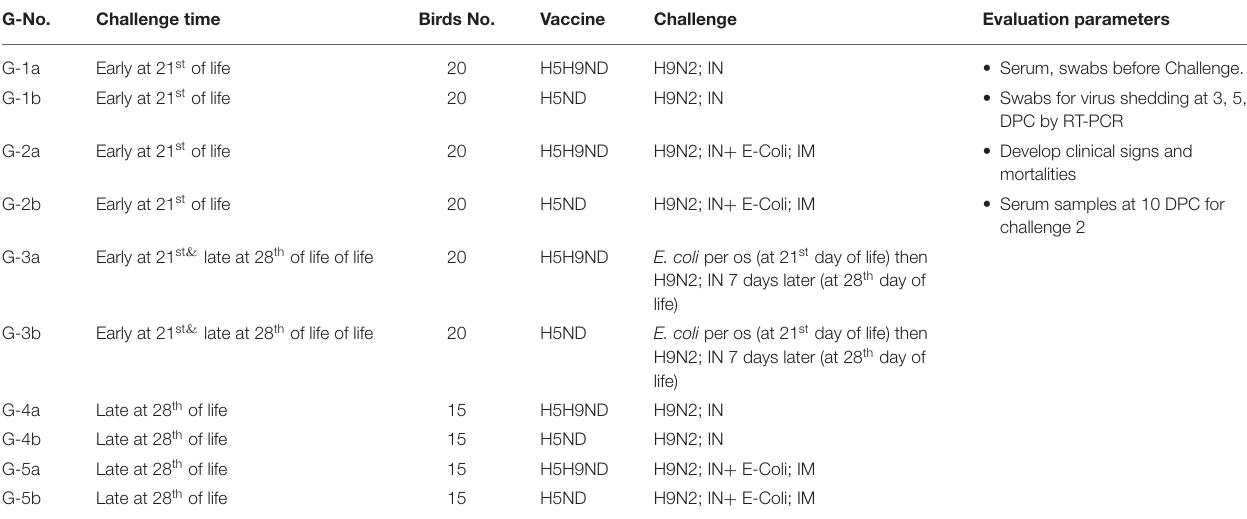
TABLE 1 | Laboratory challenge groups, Groups:1a, 2a, 3, 4, 5a, and 6a (Challenge 1 at 21st day of life) and Groups 1b, 2b, 3, 4, 5b, and 6b (Challenge 2 at 28th day of life).